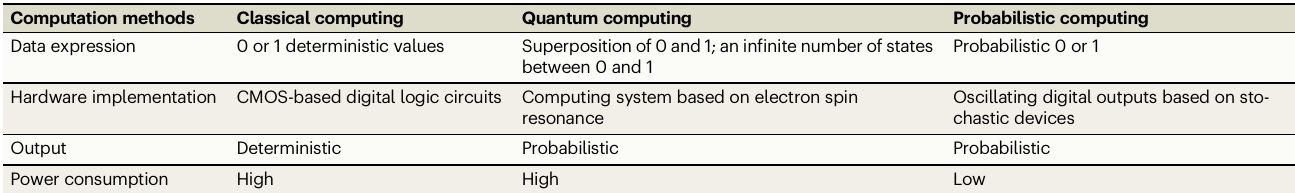
Table 1 | Comparison of different computation methods Computation